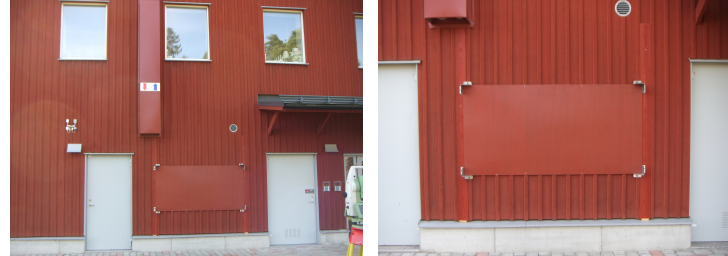
Figure 6. Left: the chosen façade with the working area mounted. Right: close-up of the working area.